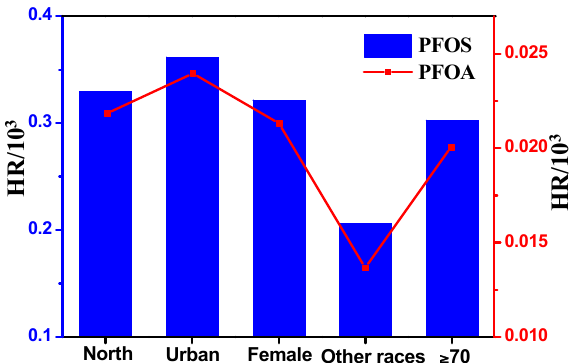
Figure 5. Health risk comparison of five population groups via intake of PFOA and PFOS from milk and dairy products.